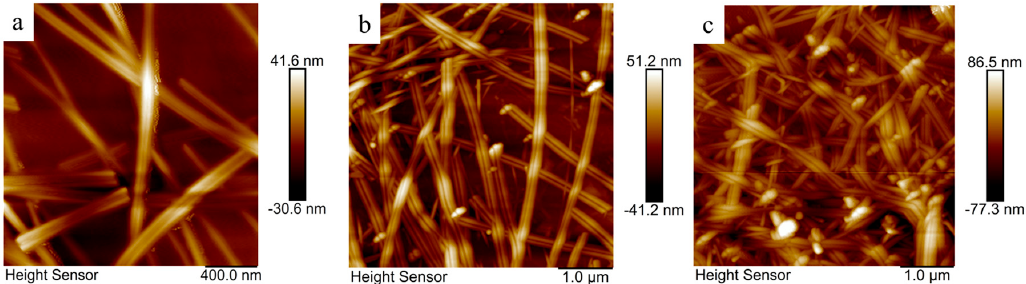
Figure 10. AFM images of films with AgNWs lengths of ( a ) 15.5 μ m, ( b ) 9.24 μ m, and ( c ) 7.86 μ m.